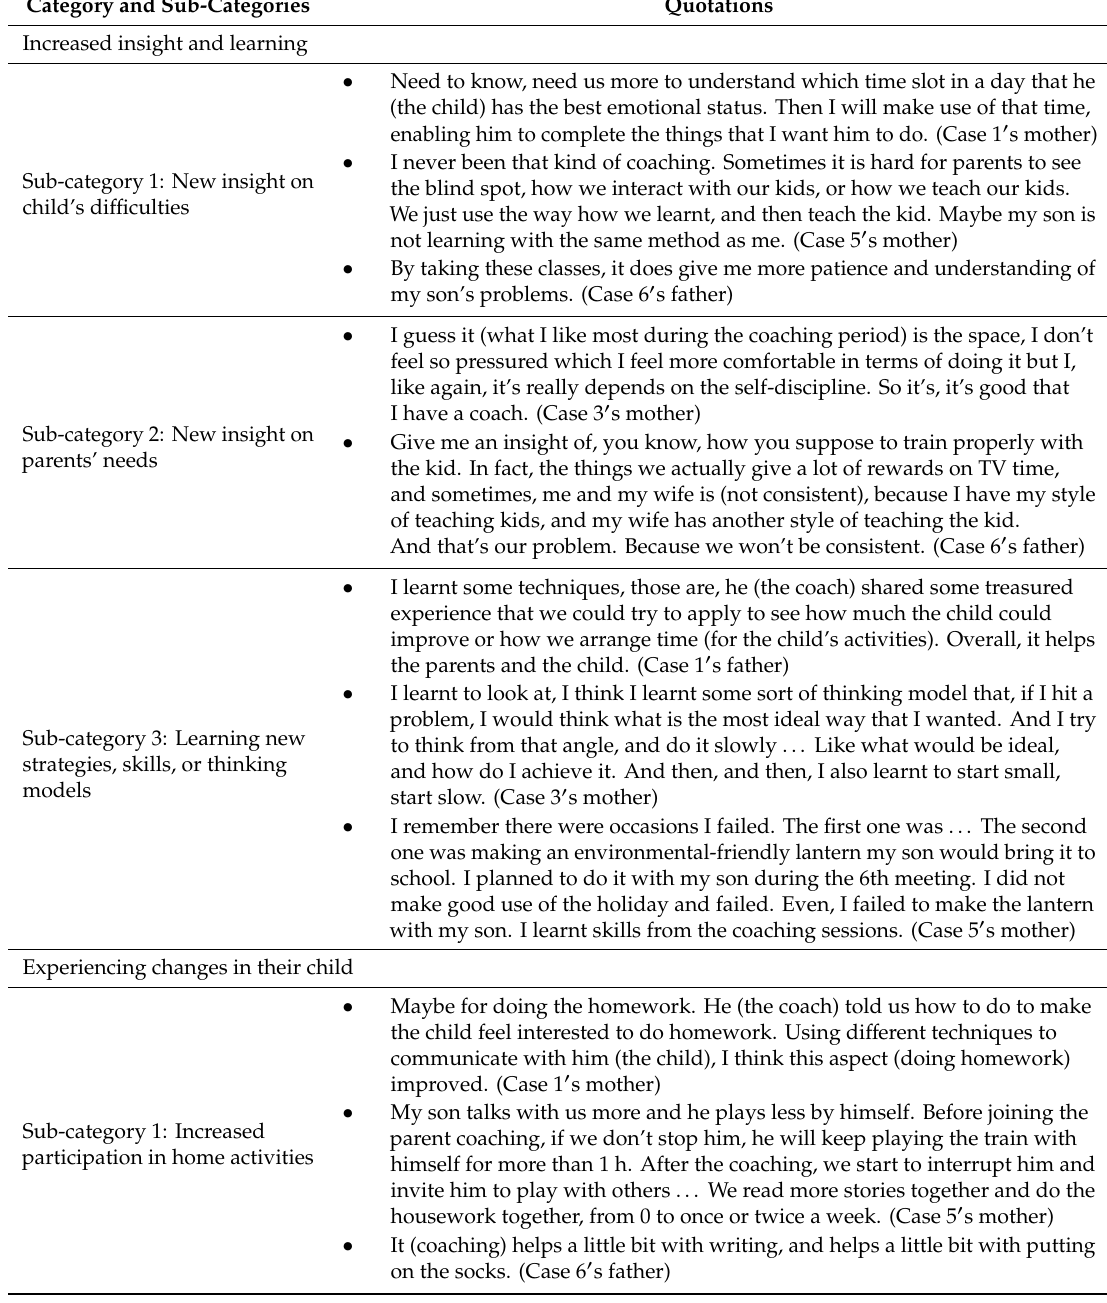
Table A1. Quotations of Identified Sub-Categories for Parents’ Experience of